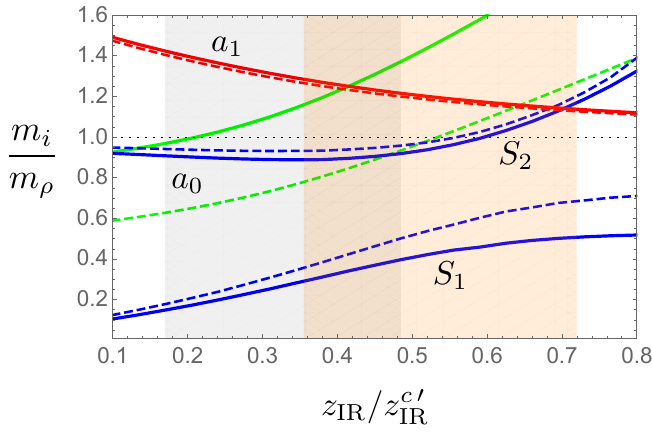
Figure 8 . As in (cid:12)gure 7 but for ^ m 2